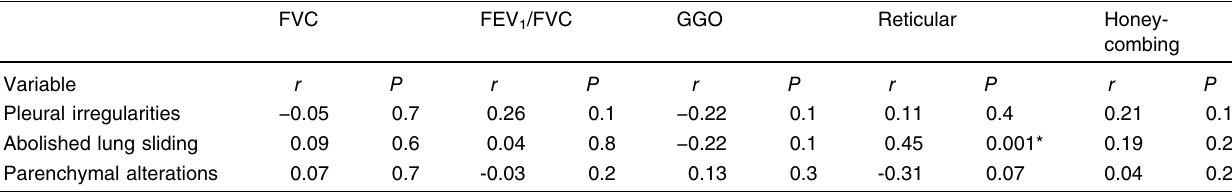
Table 4 Correlation coefficient between sonographic findings, spirometry and MDCT